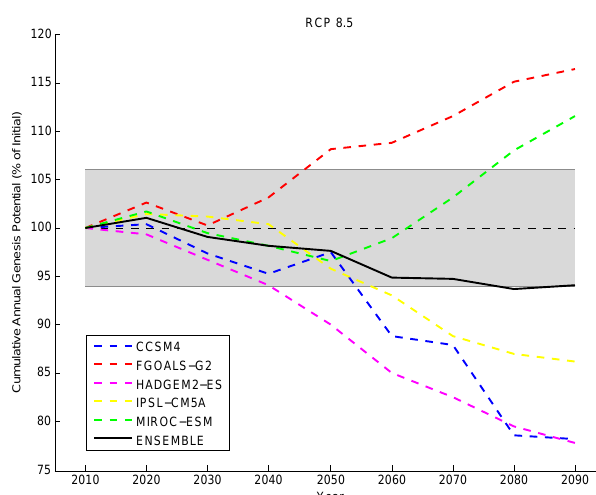
Figure 11. Cumulative annual global cyclone genesis potential in- dex simulated under the RCP8.5 scenario between 2005 and 2095. The shaded area represents the spread expected from internal vari- ability alone, from the baseline of 90 cumulative occurrences ob- served in modern day (black dashed